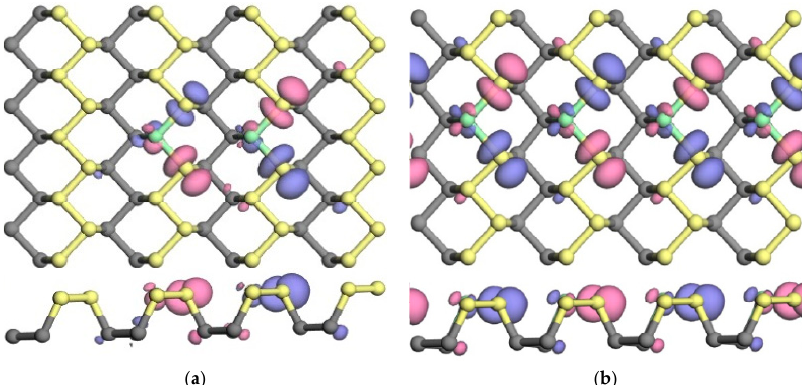
Figure 4. The spin distributions of doped phosphorenes with antiferromagnetic order: ( a ) P 62 Cl 2 and ( b ) P 60 Cl 4 . The pink and violet represent spin-up and spin-down electron density, respectively. The value of isosurface is ±0.015 e/Å 3 .